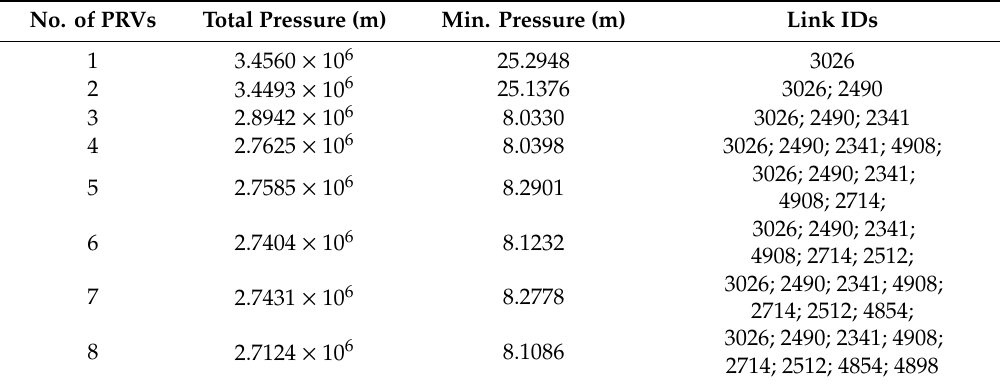
Table 6. Total pressure (24 h) with PRVs for the EXNET